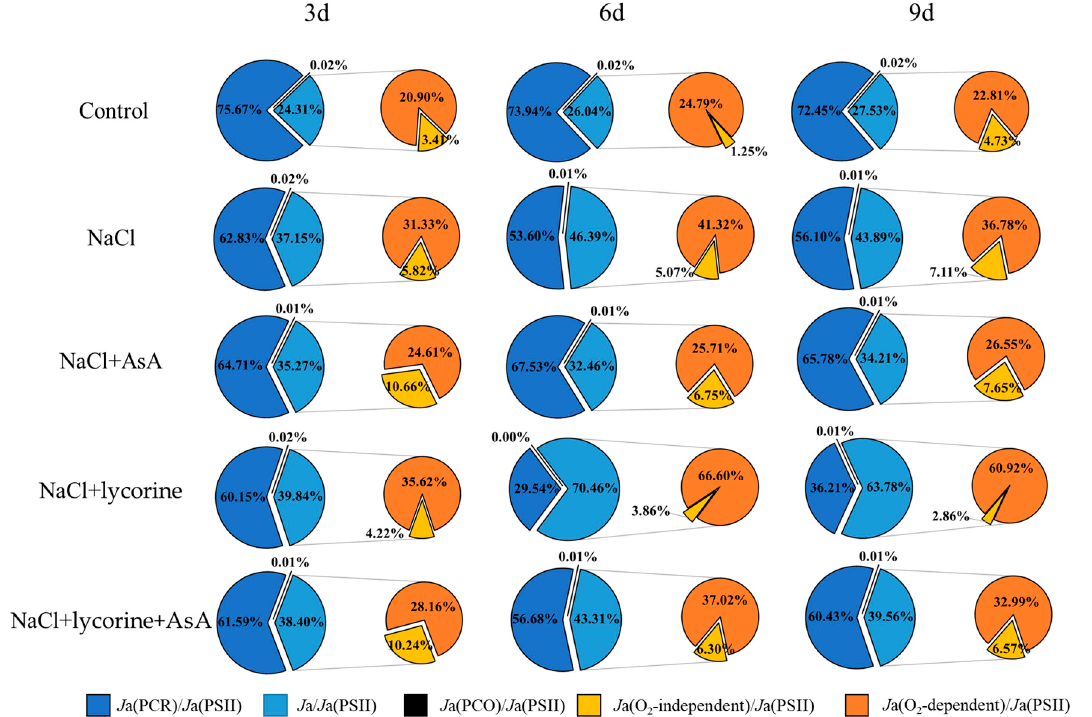
Figure 5. Ratio of J e(PCR)/ J e(PSII), J e(PCO)/ J e(PSII), J a/ J e(PSII), J a(O 2 -dependent)/ J e(PSII), and J a(O 2 -independent)/ J e(PSII) in leaves of salt-stressed tomato seedlings with or without exogenous reduced ascorbic acid (AsA) and lycorine (AsA synthesis inhibitor) spraying. Abbreviations 3d, 6d, and 9d represent the third, sixth, and ninth day after treatment, respectively. Control, no added NaCl and sprayed with distilled water; NaCl, added 100 mmol·L –1 NaCl and sprayed with distilled water; NaCl + AsA, added 100 mmol·L –1 NaCl and sprayed with 0.5 mmol·L –1 AsA; NaCl + lycorine, added 100 mmol·L –1 NaCl and sprayed with 0.25 mmol·L –1 lycorine; NaCl + lycorine + AsA, added 100 mmol·L –1 NaCl and sprayed with 0.25 mmol·L –1 lycorine plus 0.5 mmol·L –1 AsA. Values are means ± SD ( n = 3).